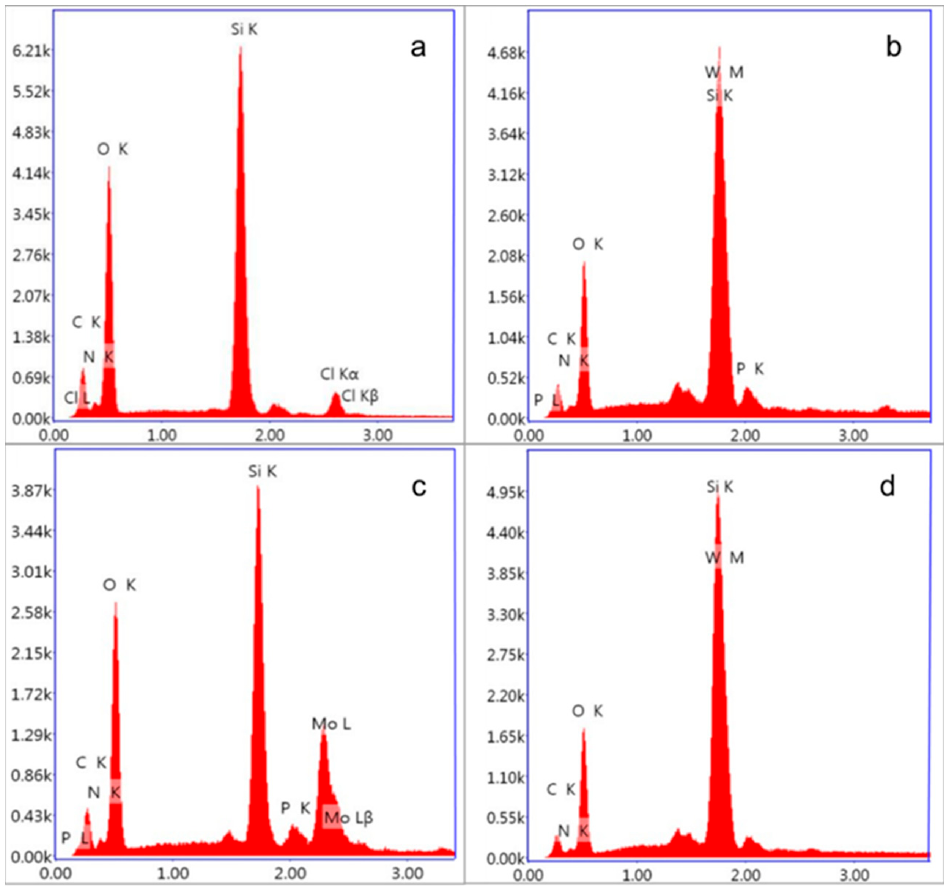
Figure 6. EDS analysis of [BMIM]Cl-based MCF ( a ), [BMIM] 3 PW 12 O 40 -based MCF ( b ), [BMIM] 3 PMo 12 O 40 -based MCF ( c ), and [BMIM] 4 SiW 12 O 40 -based MCF ( d ).